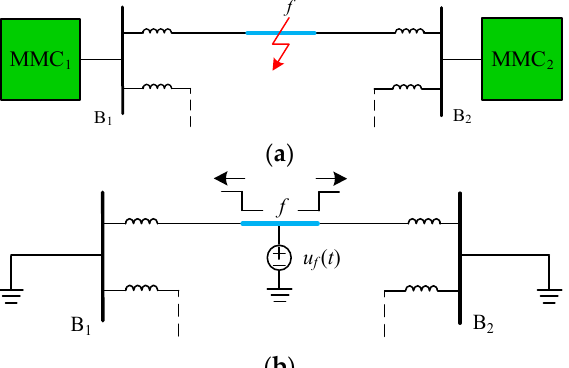
Figure 10. Diagram of fault network decomposition: ( a ) A fault f on the line; ( b ) Fault superimposed network.